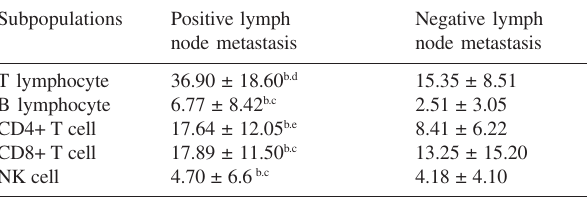
Table 2 - Subpopulations of Immunocytes in Tumor Tissue from Breast Carcinoma Specimens with Respect to Lymph Node Involvement